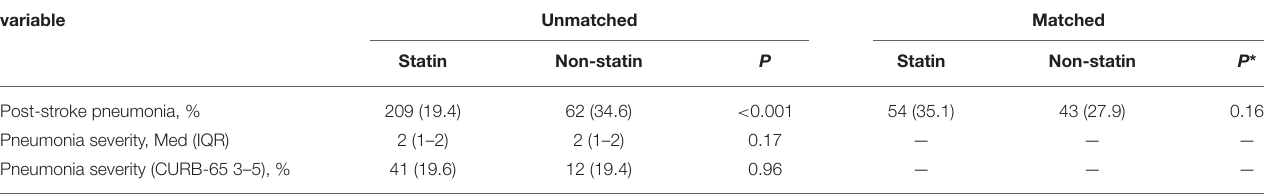
TABLE 2 | Outcome measures of unmatched and propensity-matched subgroups.